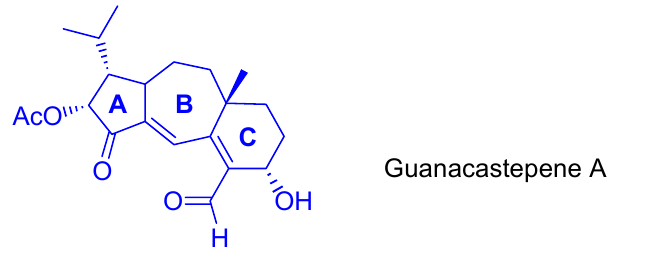
Figure 2. Rings A, B and C in natural terpene guanacastepene